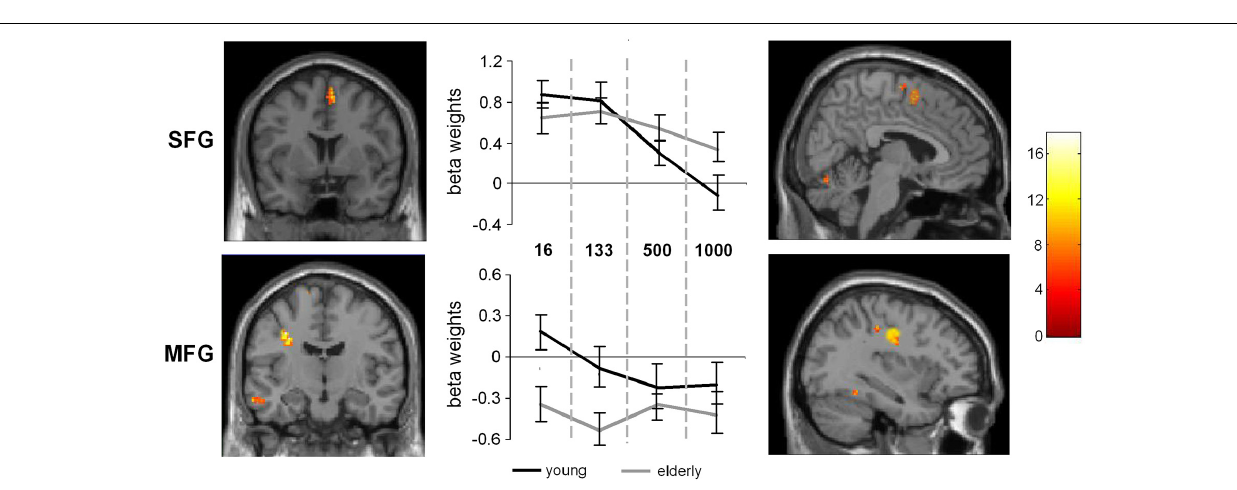
middle part of the figure denotes the signal intensities (beta weights mean and standard deviation) for the MFG and SFG regions across the different SOA conditions, separated the young and late-middle aged